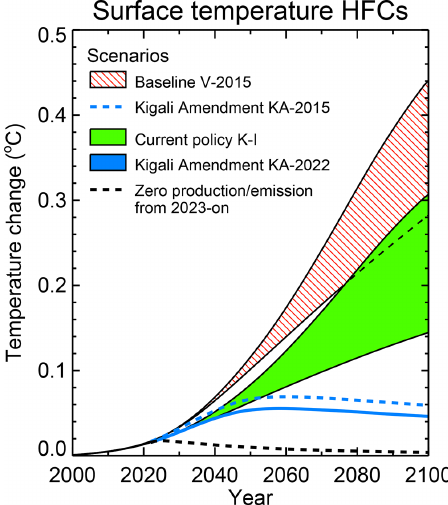
Figure 7. Contribution of HFCs to the global average surface warming for the V-2015 baseline scenario without measures on HFC consumption and the current policy Kigali-independent (K-I) scenario. The bands represent the upper and lower ranges of these scenarios. Also shown are the effects of the phasedown of HFCs, following controls of the Kigali Amendment (KA-2022), and a hy- pothetical scenario which assumes that the global production of emissions of HFCs would cease in 2023. No range is shown for the Kigali Amendment scenario since the lower and upper range scenarios virtually coincide. The surface temperature change is cal- culated using the MAGICC6 model (Meinshausen et al., 2011a). The curves contain the contributions of all HFCs, except